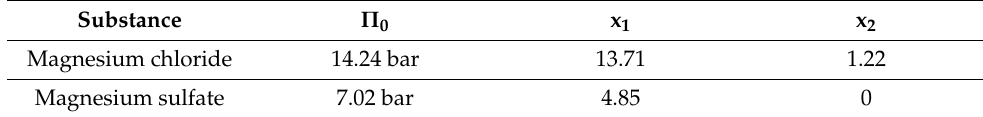
Table 3. Parameters of the empirical fit function (Equation